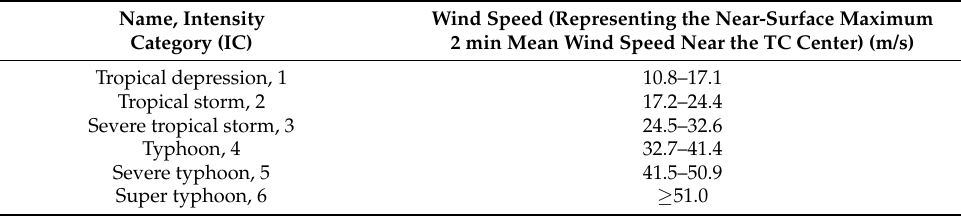
Table 1. Intensity Category according to CMA (https://data.cma.cn/en, accessed on 22 April 2022)